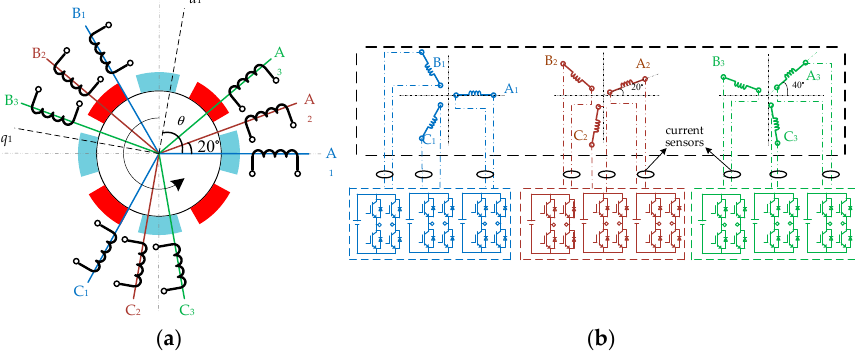
Figure 1. ( a ) Winding structure of nine-phase PMSM; ( b ) H-bridge drive topology. The probability of faults increases with the number of current sensors required for the nine-phase PMSM drives. The fault diagnosis and tolerant control of nine-phase PMSM drives are shown in Figure 2.